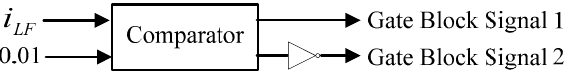
Figure 6. Extinction angle control of LFAC.